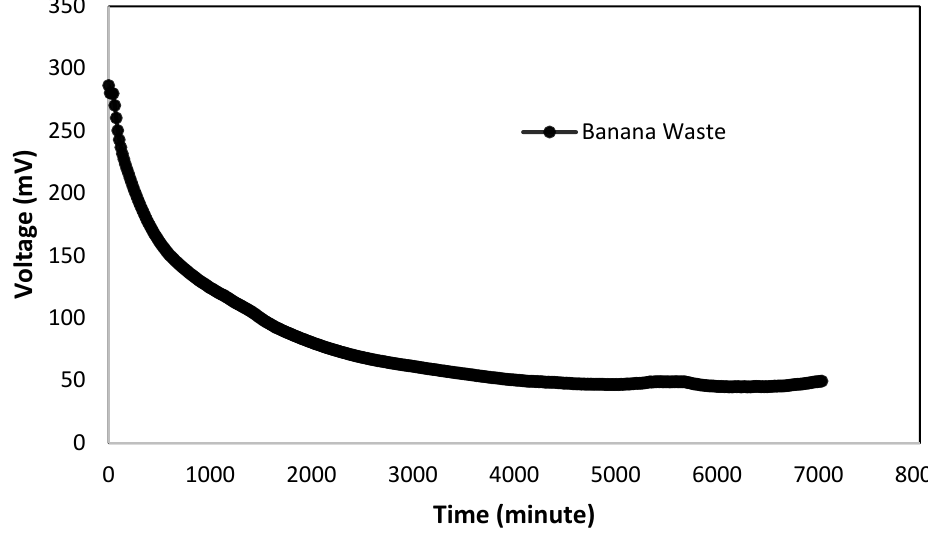
Figure 5. Voltage generation by MFC from BW digestate-feeding.